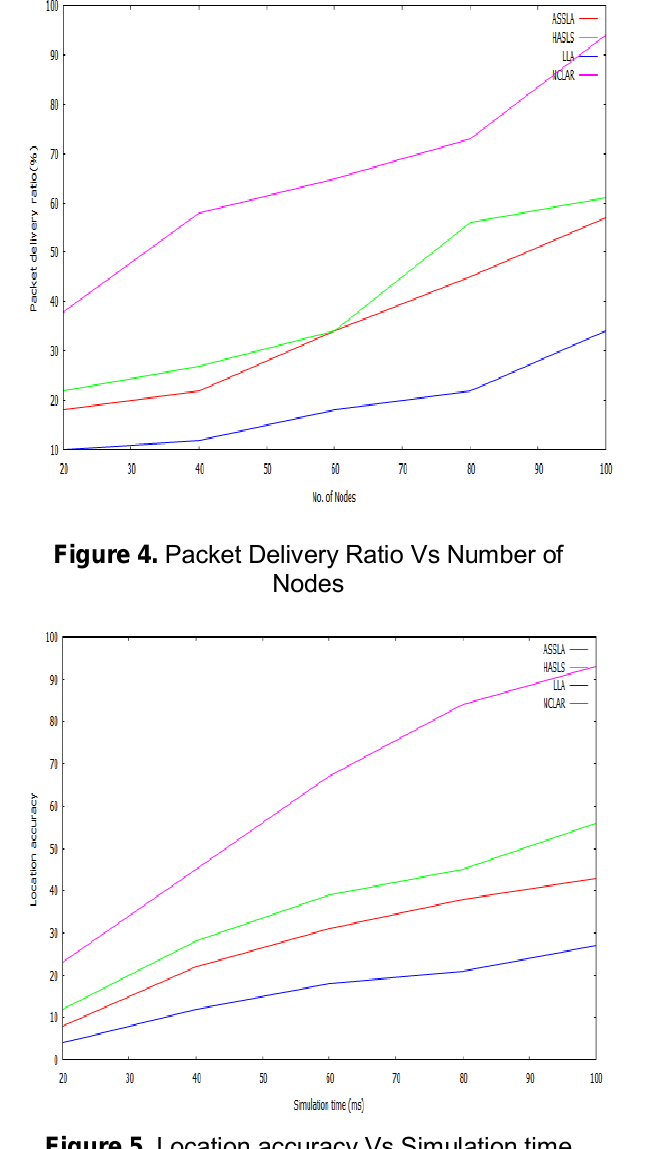
Figure 5. Location accuracy Vs Simulation time